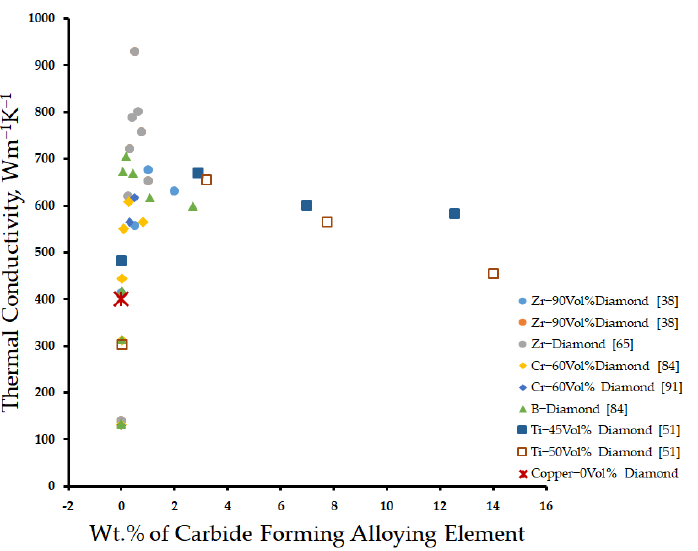
Figure 3. Effect of the content of carbide-forming alloying element in the copper matrix on the thermal conductivity of the composite.